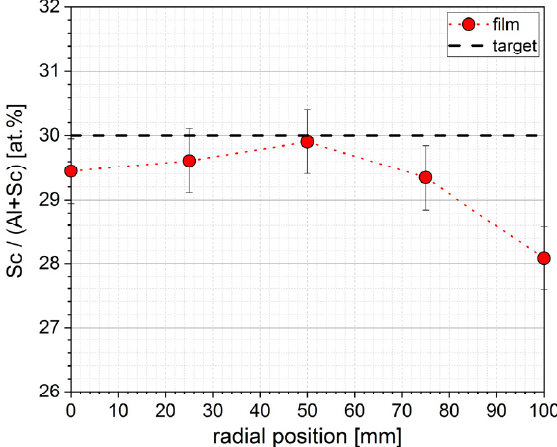
Figure 2. EDS measurement of Sc content in AlScN and comparison to the Al 0.7 Sc 0.3 target composition. Figure 3 shows the θ –2 θ scans of AlScN with 2.5 µ m and 0.9 µ m thicknesses on Si/Ti/Pt with a 5 nm Ti and 40 nm Pt seed layer for different pulse modes and radial positions. All films were highly c-axis-oriented, with (002) peaks being the main intensity by far. The 2.5 µ m-thick films deposited with a more unipolar pulse mode (S u = 90%), revealing that there were also weak peaks of (102) and (103) orientation present, although those had a very small intensity of 1:3500 relative to the (002) peak. On the other hand, the films deposited with a lower share of unipolar pulse mode (S u = 60%) exhibited no (102) or (103) peaks in the inner radial positions, while they appeared only at the edge of the coating area (r = 90 mm), with intensity ratios to the (002) peak being 1/1000 and 1/2000, respectively. The thinner films with 900 nm thickness, on the other hand, exhibited no visible (102) or (103) peaks, regardless of pulse mode or radial position, indicating a high crystalline quality over the whole coating area for the thinner films, similar to results for thickness-dependent occurrences of AOG reported in [12].